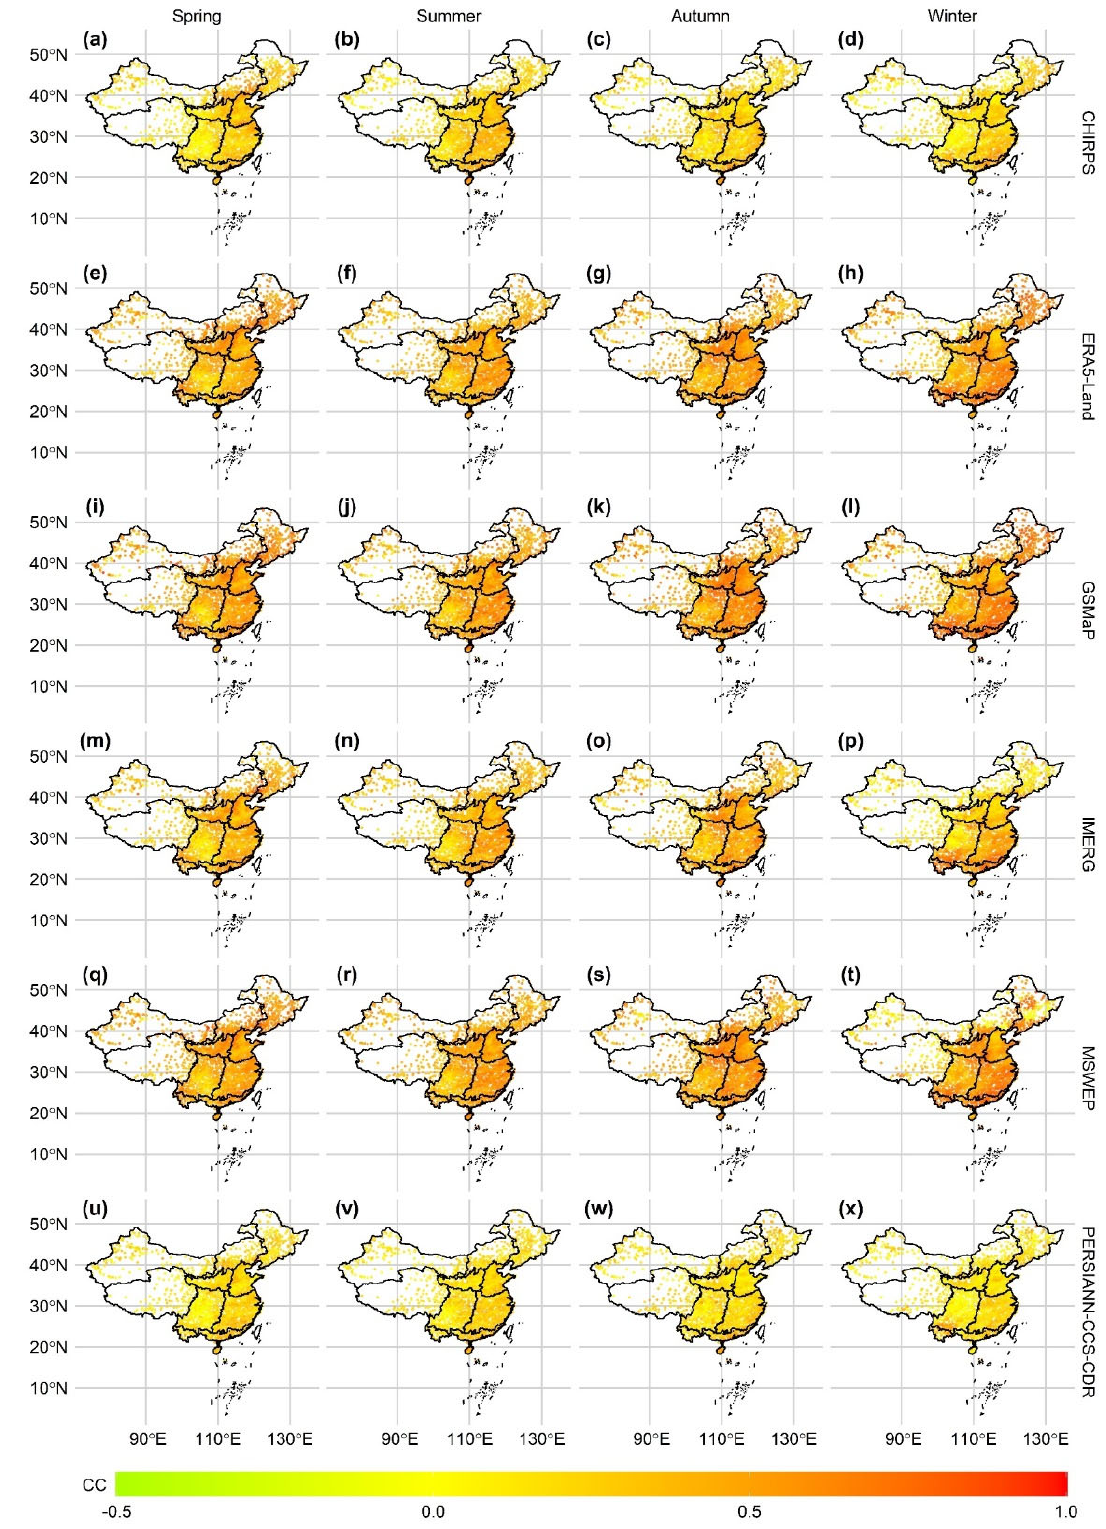
Figure 9. Distribution of CC values of six products for different seasons between 2015 and 2019. From top to bottom: ( a – d ) CHIRPS, ( e – h ) ERA5-Land, ( i – l ) GSMaP, ( m – p ) IMERG, ( q – t ) MSWEP and ( u – x ) PERSIANN ‐ CCS ‐ CDR.